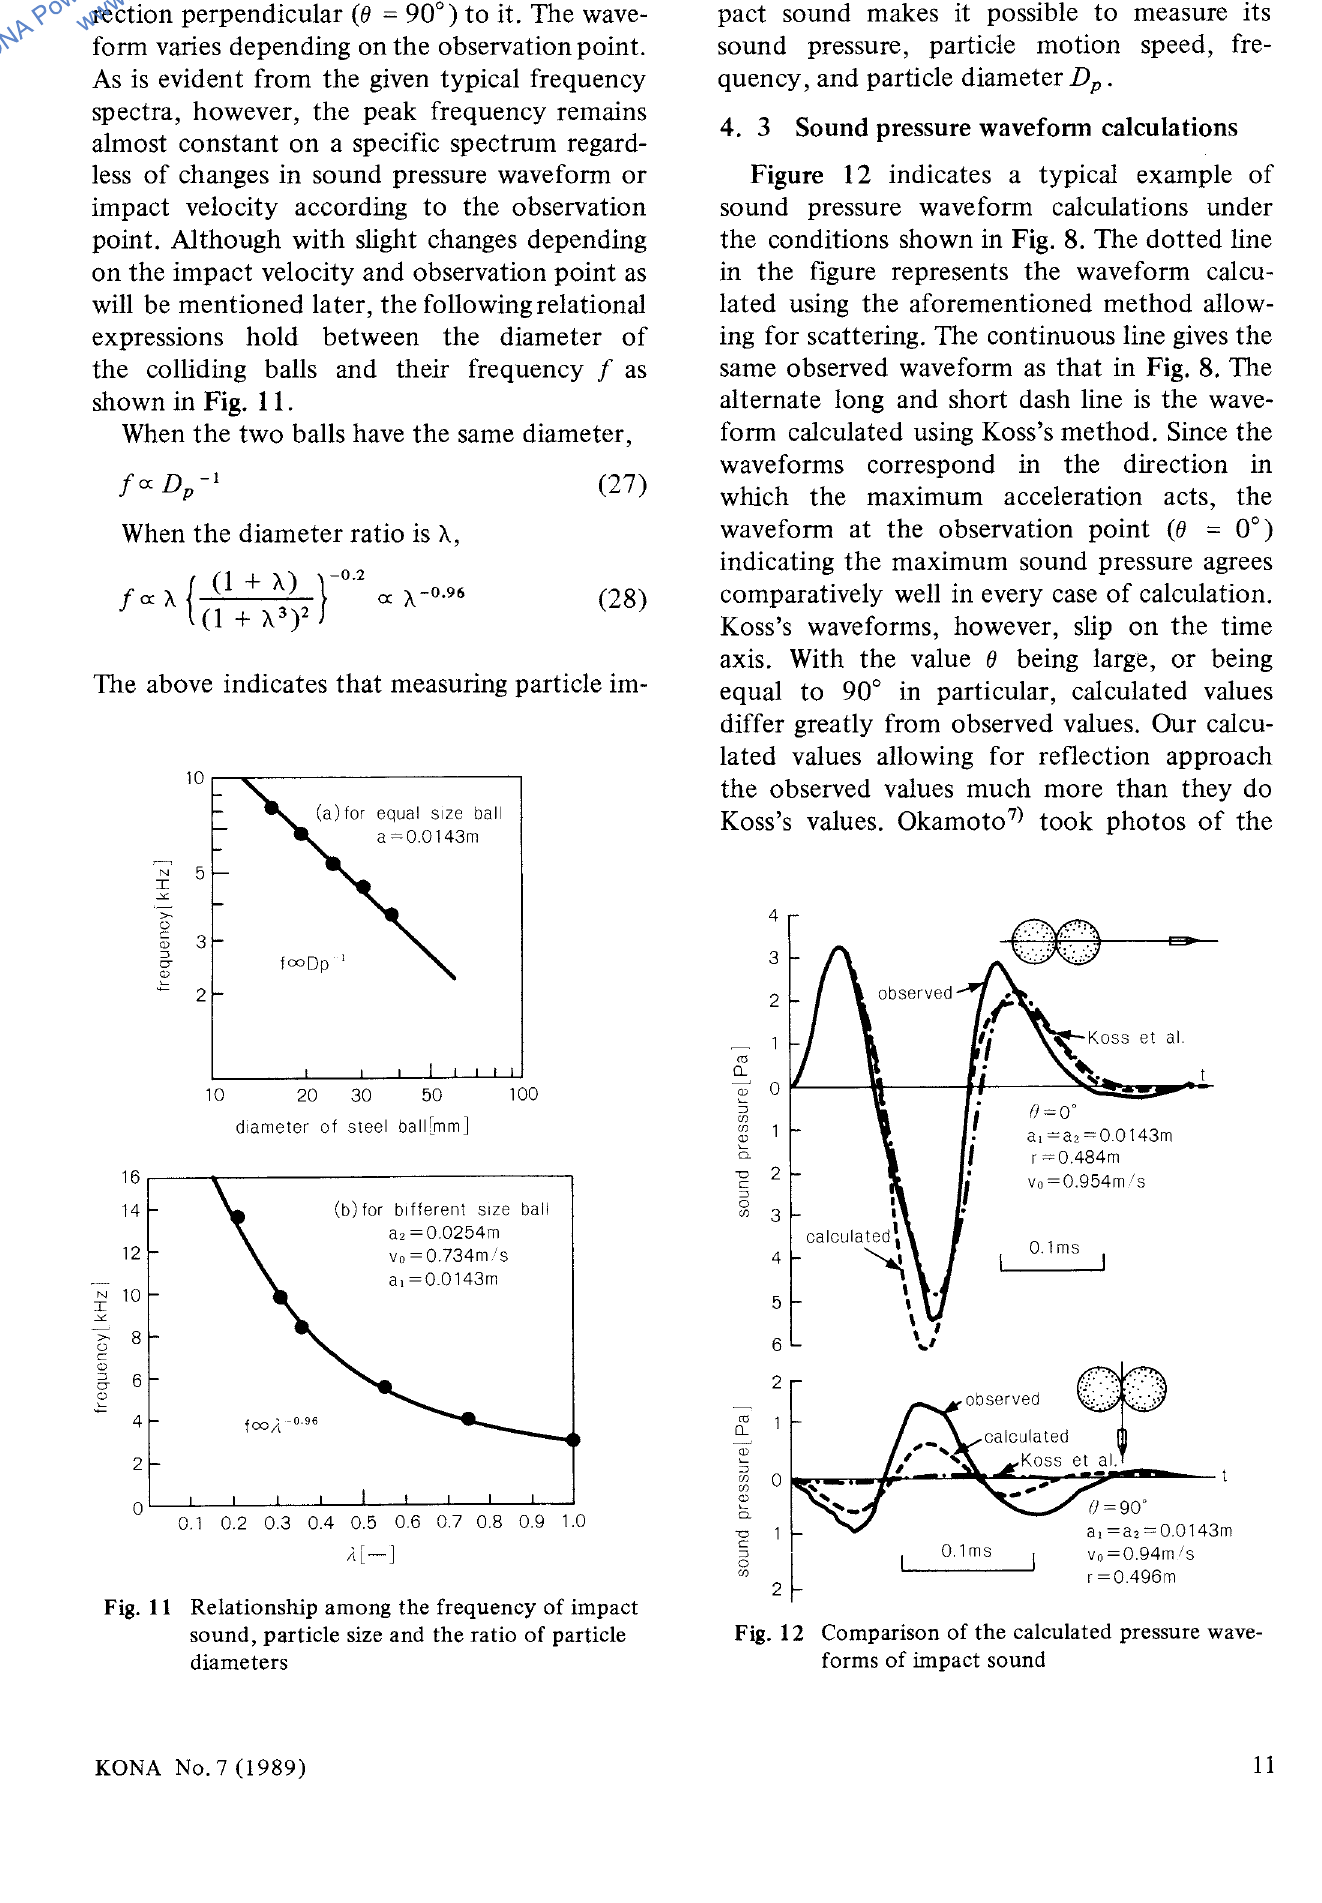
Fig. 11 Relationship among the frequency of impact sound, particle size and the ratio of particle diameters